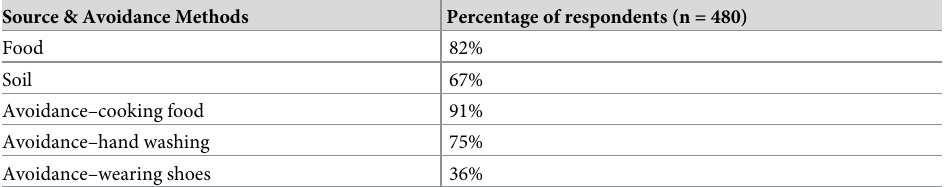
Table 2. Household survey responses regarding sources and avoidance methods of STH infections. Participants were asked whether food and/or soil were a source of STH and whether cooking food, hand washing and wearing shoes were methods of avoidance. S1 Data.